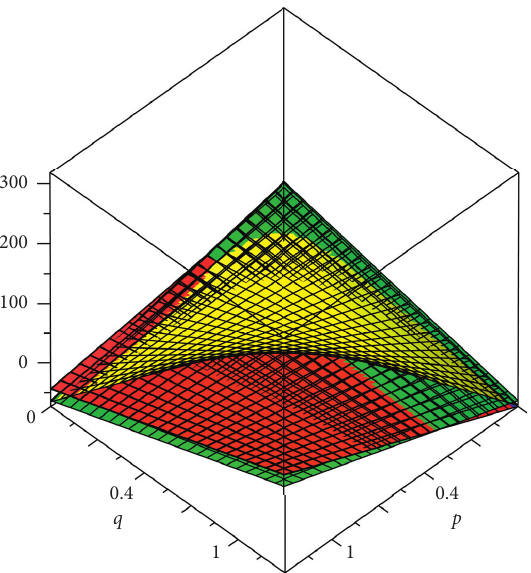
Figure 17: Comparison of the first Gourava index.